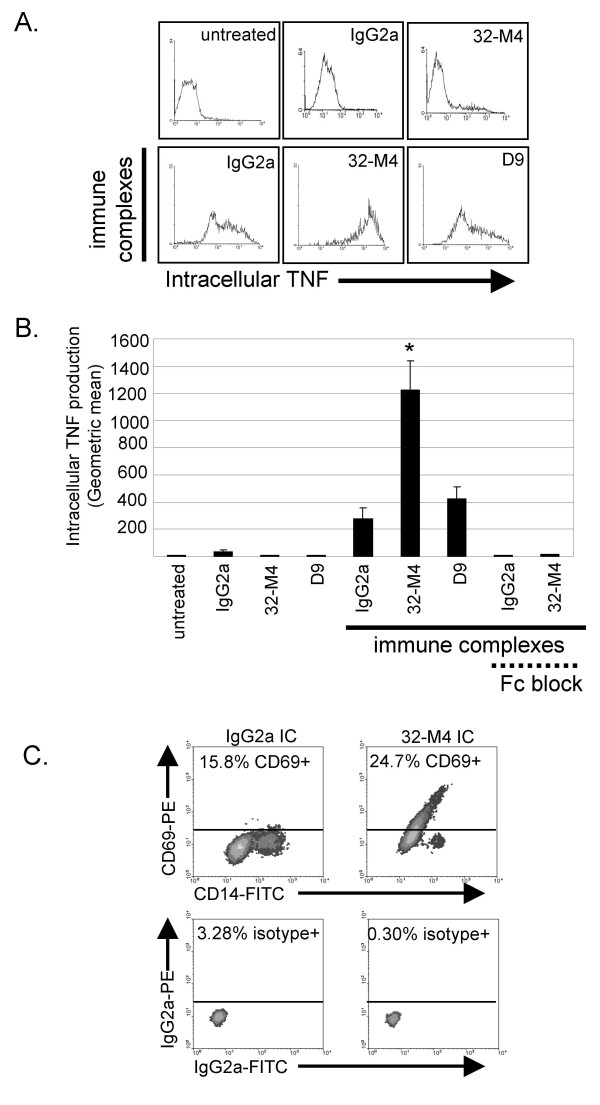
CD8α enhances monocyte TNF production in a FcγR-dependent manner. Monocytes were incubated with anti-CD8α or isotype mAb alone or in immune-complexes. Excess Fc fragment was used to block FcγR. TNF production was measured by intracellular flow cytometry after 5 h (gated on CD14hi monocytes). A. Histograms are representative results. B. Bar graph represents average geometric mean of intracellular TNF from four separate experiments with monocytes from different donors. Standard error of the mean is designated by error bars. *: p < 0.05 non-paired t-test. C. CD69 and CD14 regulation induced by immune-complexes (IC) is enhanced by CD8α ligation (representative example).